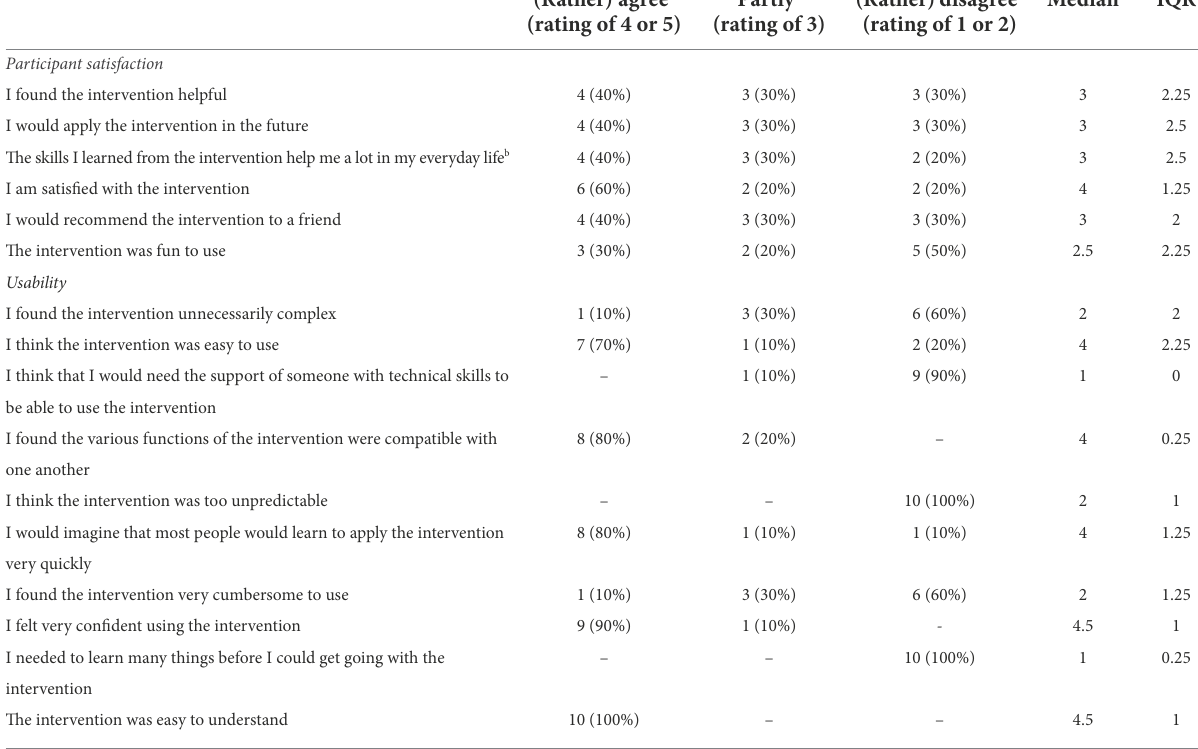
TABLE 2 Participant satisfaction and